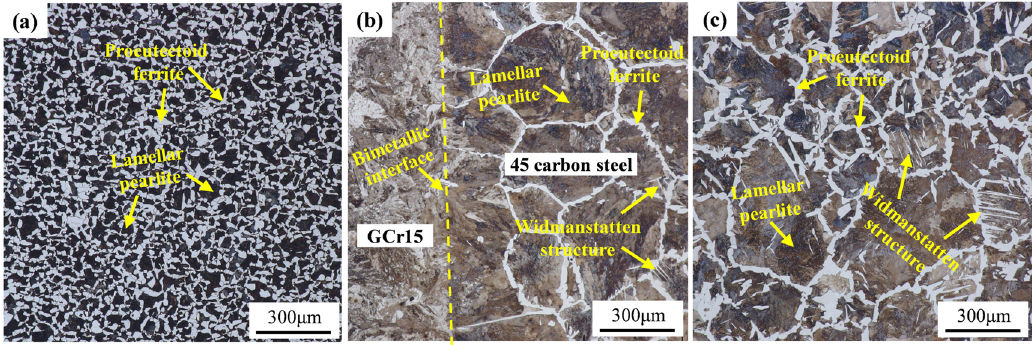
Figure 10: Microstructure of the roll core surface area ( a ) before and ( b and c ) after the ESRC